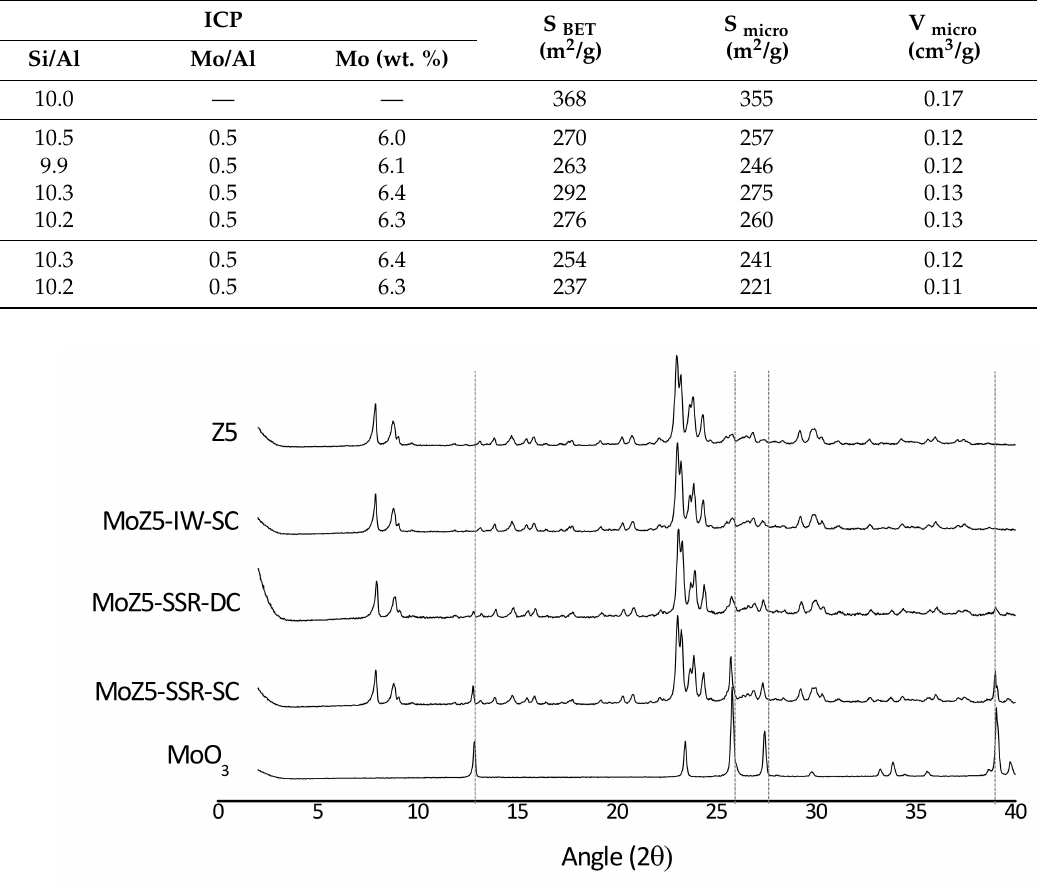
Table 1. Physico-chemical properties of the Mo/ZSM-5 catalysts.